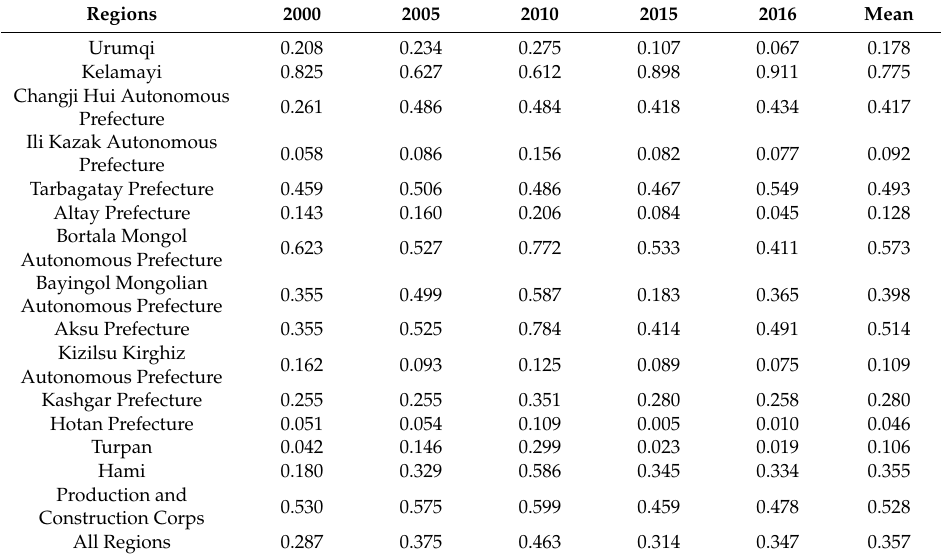
Table 7. The ratio of plastic-mulched area to total cropland area in each prefecture or city in Xinjiang.